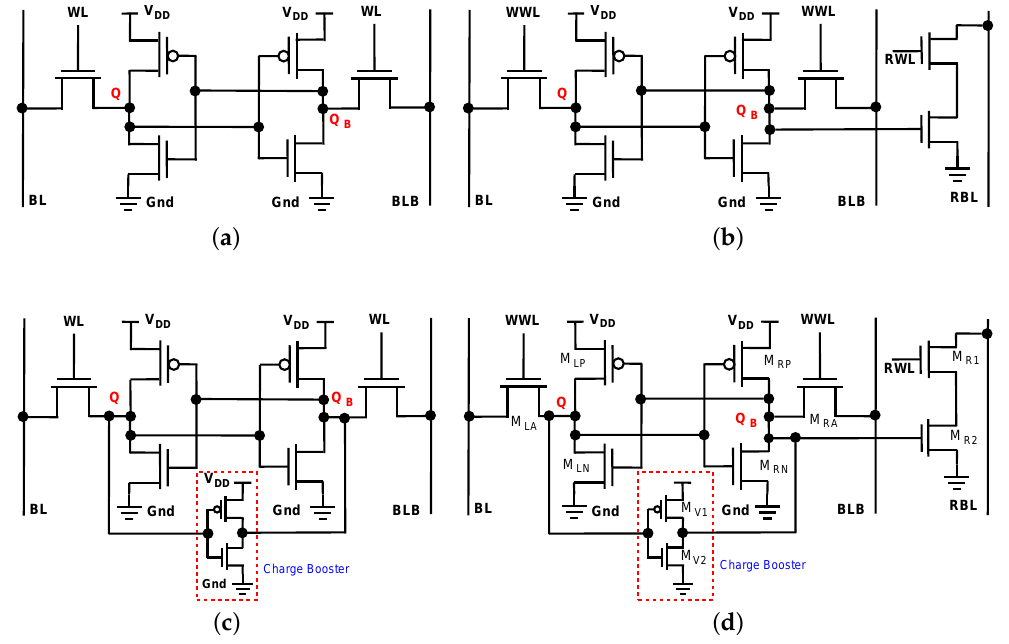
Figure 2. Schematic of different SRAM Cells: ( a ) 6T SRAM cell ( b ) Read decoupled 8T (RD8T) SRAM cell after ( c ) Asymmetric radiation-hardened 8T (AS8T) SRAM cell after ( d ) Proposed asymmetric radiation-hardened (AS10T) SRAM Cell with improved